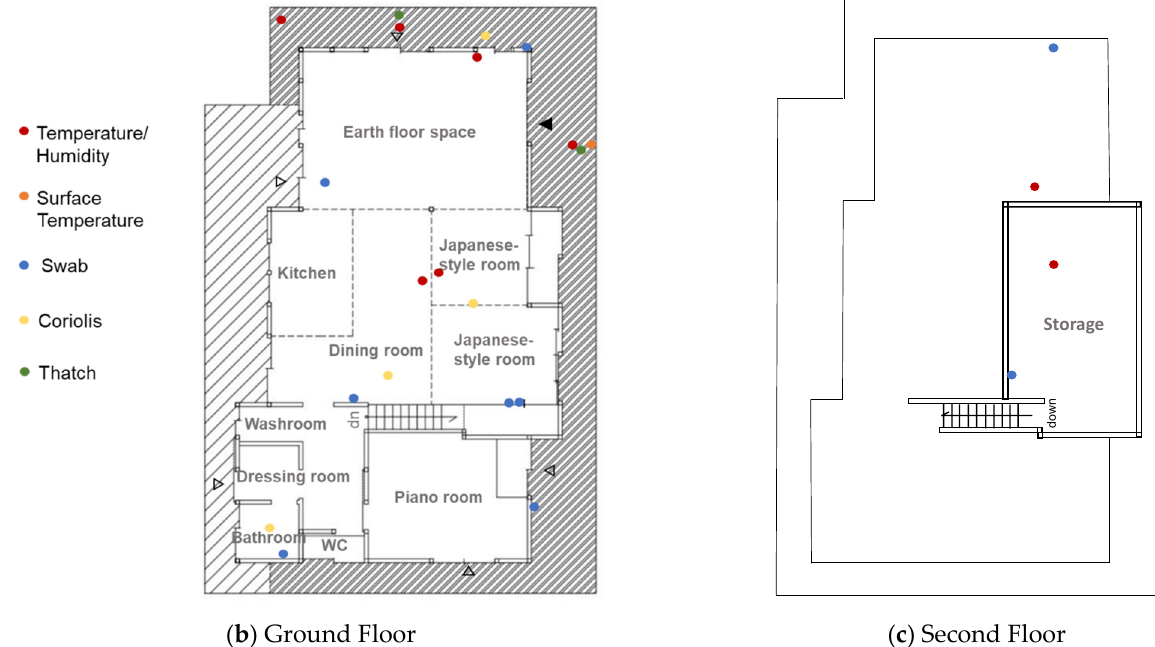
Figure 2. ( a ) Floorplan of the subject house. ( b , c ) The temperature/humidity measurement points (red and orange dots) and the microbial sampling locations (blue, yellow, and green dots) were plotted on the plan. Coriolis (yellow plots) means sampling locations using a biological air sampler (Coriolis Micro, Bertin Technologies, France). ▲ indicates the main entrance, and △ indicates the back entrances.